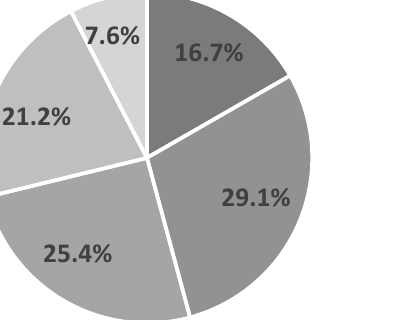
Figure 1. How often, in total (regardless of purpose), do you visit the forest on average per year (winter and summer)? (data in %, source C2018).